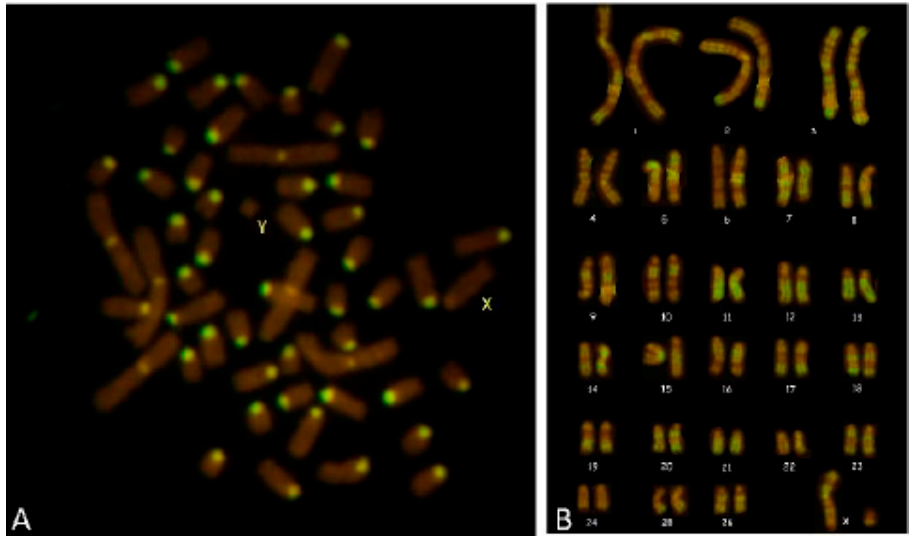
Figure 7. Case 3 ewe (2n = 54, XY). ( A ) C-banding pattern (CBA), sex chromosomes are labeled; ( B ) R-banding (RBA) karyotype.